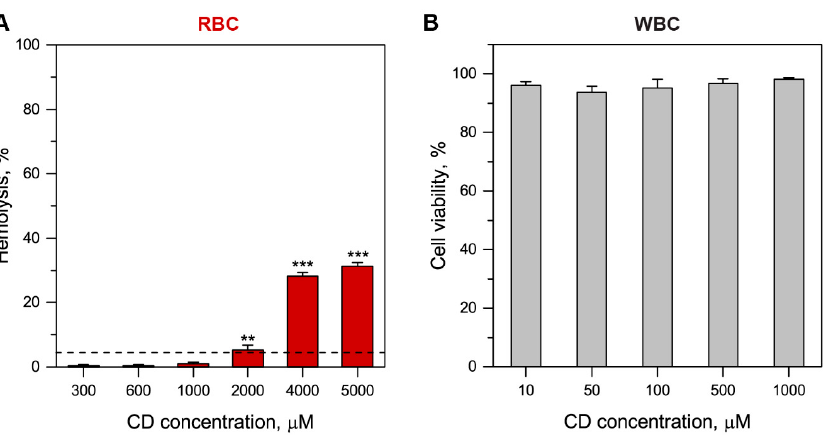
Figure 3. Cytotoxicity of Me- β -CD. ( A ) Hemolysis assay and ( B ) WBC viability in the function of Me- β -CD concentration. Hemolysis was analyzed for 2-h incubation with Me- β -CD, while the WBC viability was assessed using PI at 20 h post-incubation. Data represent averages ± SD ( n = 3; ** p < 0.01, *** p < 0.001 using the one-sample t-test (µ = 0)). Dashed line corresponds to 5% of hemolysis.